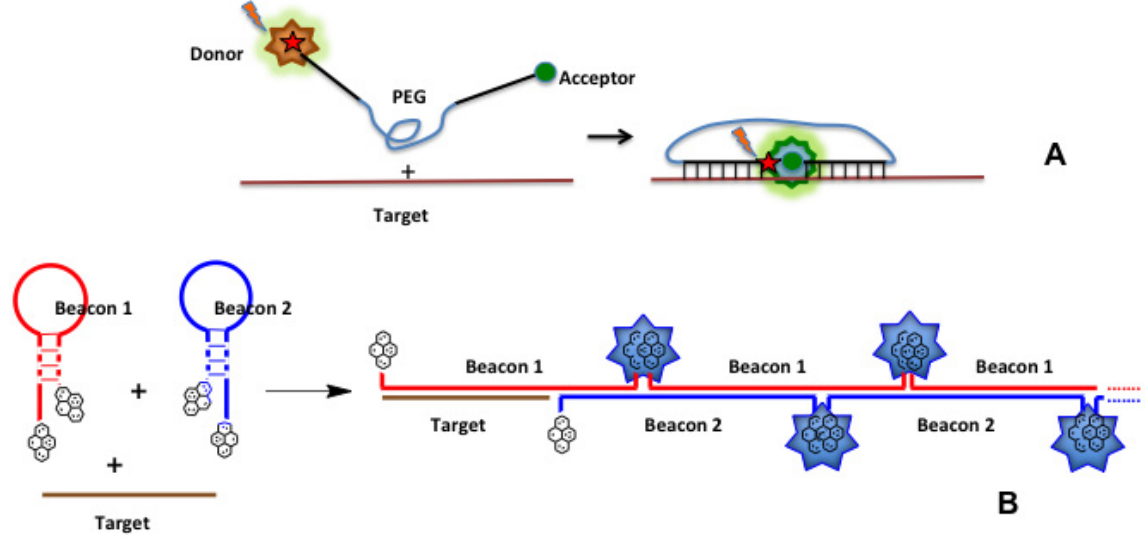
Figure 14. New types of molecular beacons. ( A ) hybrid molecular probe with two antiparallel oligonucleotide strands linked by a long poly(ethyleneglycol) chain [204]. Oligonucleotides complementary to adjacent target sequences are labeled by donor and acceptor fluorophores, respectively. Upon hybridization the FRET effect is observed. ( B ) Hybridization chain reaction [199]. Two molecular beacons are partially complementary and bear two pyrene moieties separated in space. Upon addition of a target, hybridization chain reaction is initiated; two pyrenes from adjacent probes appear in a close proximity and emit excimer fluorescence, which is amplified due to formation of several excimers on one target